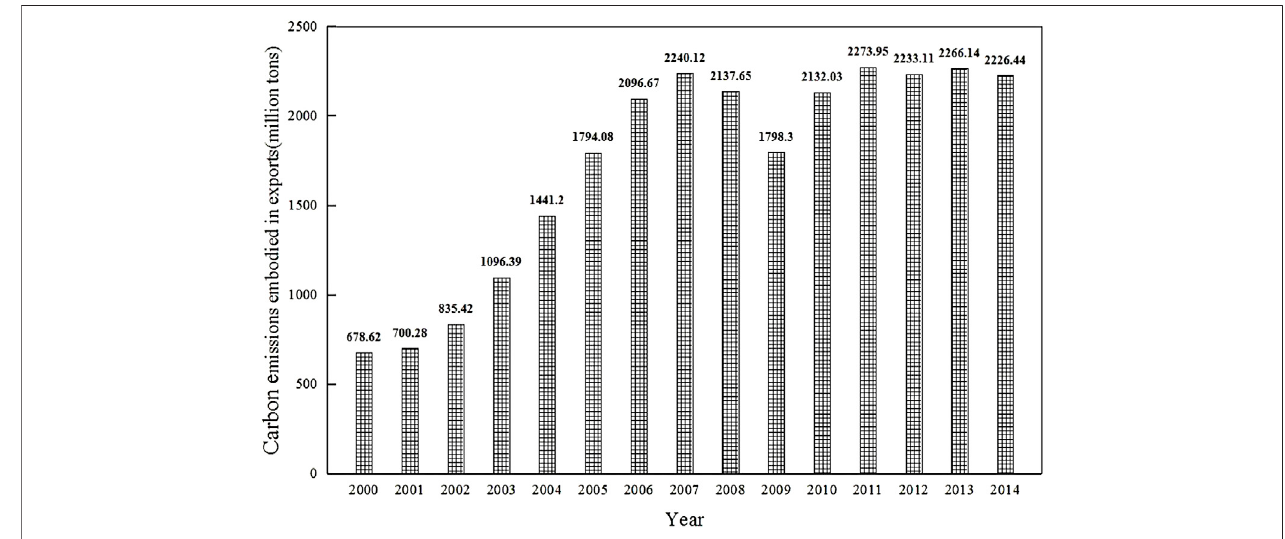
FIGURE 1 | Carbon emissions embodied in China ’ s exports from 2000 to